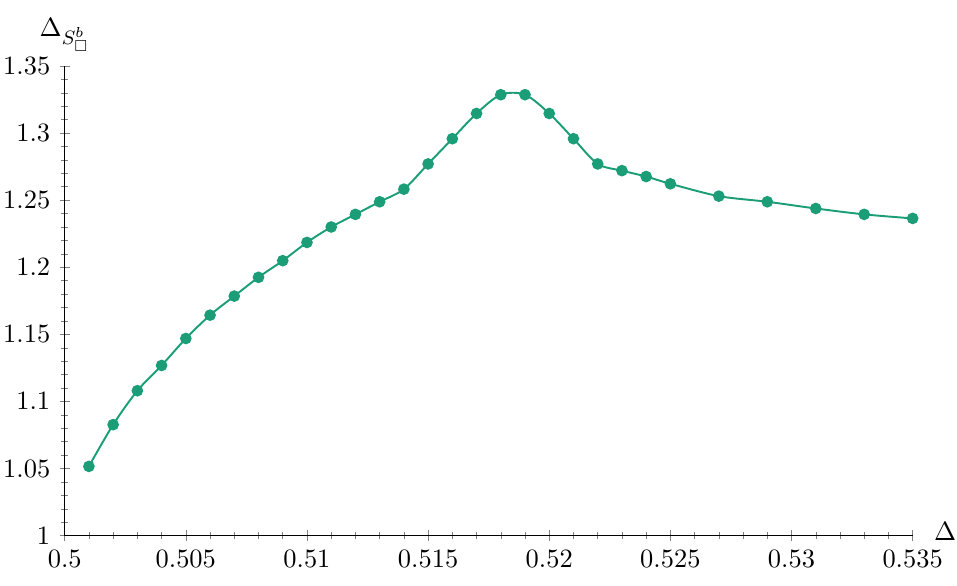
Figure 5 . The dimension of S b of (cid:12)gure 2. The markers indicate the points at which we have computed the